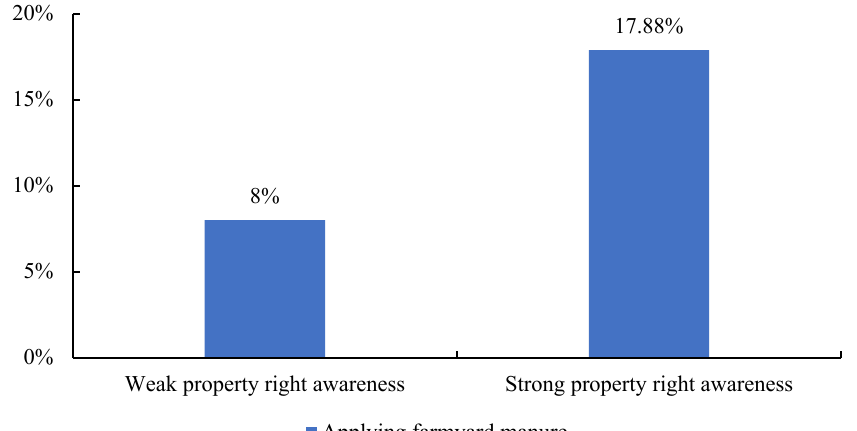
Figure 3. Relationship between land property rights security perception and cultivated land quality protection.